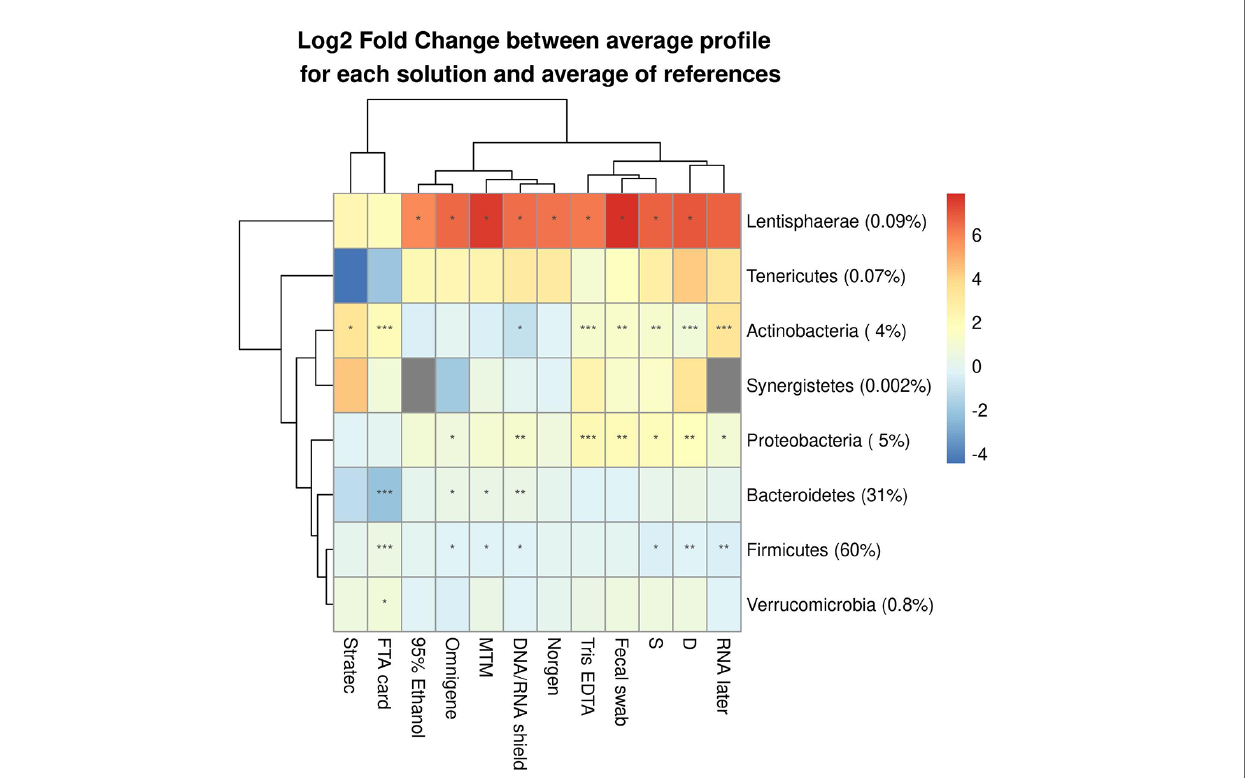
FIGURE 5 | Differentially abundant bacterial phyla between samples and their references among the 10 tested DNA stabilizing solutions. The median log2-fold change of average pro fi les is shown with the signi fi cance according the corresponding paired Wilcoxon test. (*) indicates fdr<0.05, (**) indicates fdr<0.01, (***) indicates